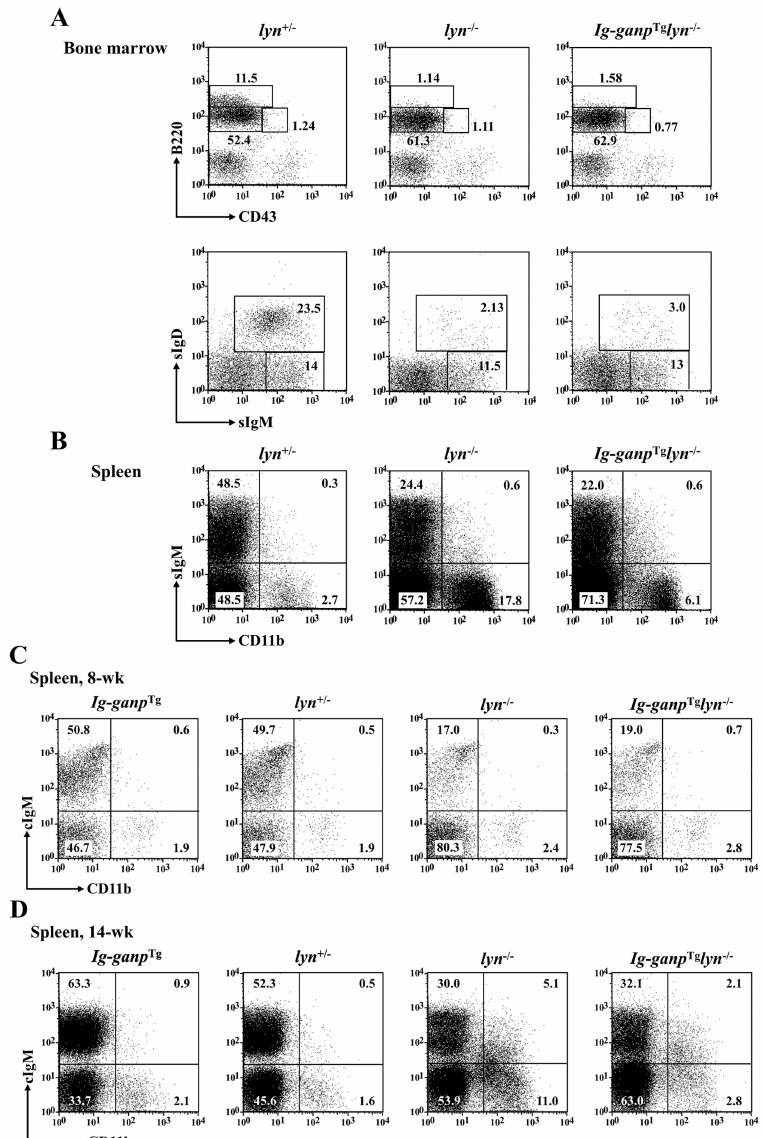
Figure 2. Cell di ff erentiation into B-cell / macrophage biphenotypic cells by GANP in a Lyn-deficient state. Early B-cell di ff erentiation compared among lyn +/ − , lyn − / − , and Ig - ganp Tg lyn − / − mice. ( A ) Bone marrow cells isolated from 14-week-old mice were stained with B220, CD43, IgM, and IgD to identify pro-B, pre-B, immature B, and mature B-cell fractions. Although there are no di ff erences of pro-B, pre-B, and immature B-cell populations, sIgM + sIgD + mature B-cell population is reduced in lyn − / − and Ig-ganp Tg lyn − / − mice. ( B ) sIgM − CD11b + population in the spleen is reduced in Ig - ganp Tg lyn − / − mice compared to lyn − / − mice. ( C , D ) cIgM + CD11b + cell population is increased in 14-week-old lyn − / − mice, whereas the population is almost normal in 14-week-old Ig-ganp Tg lyn − / −